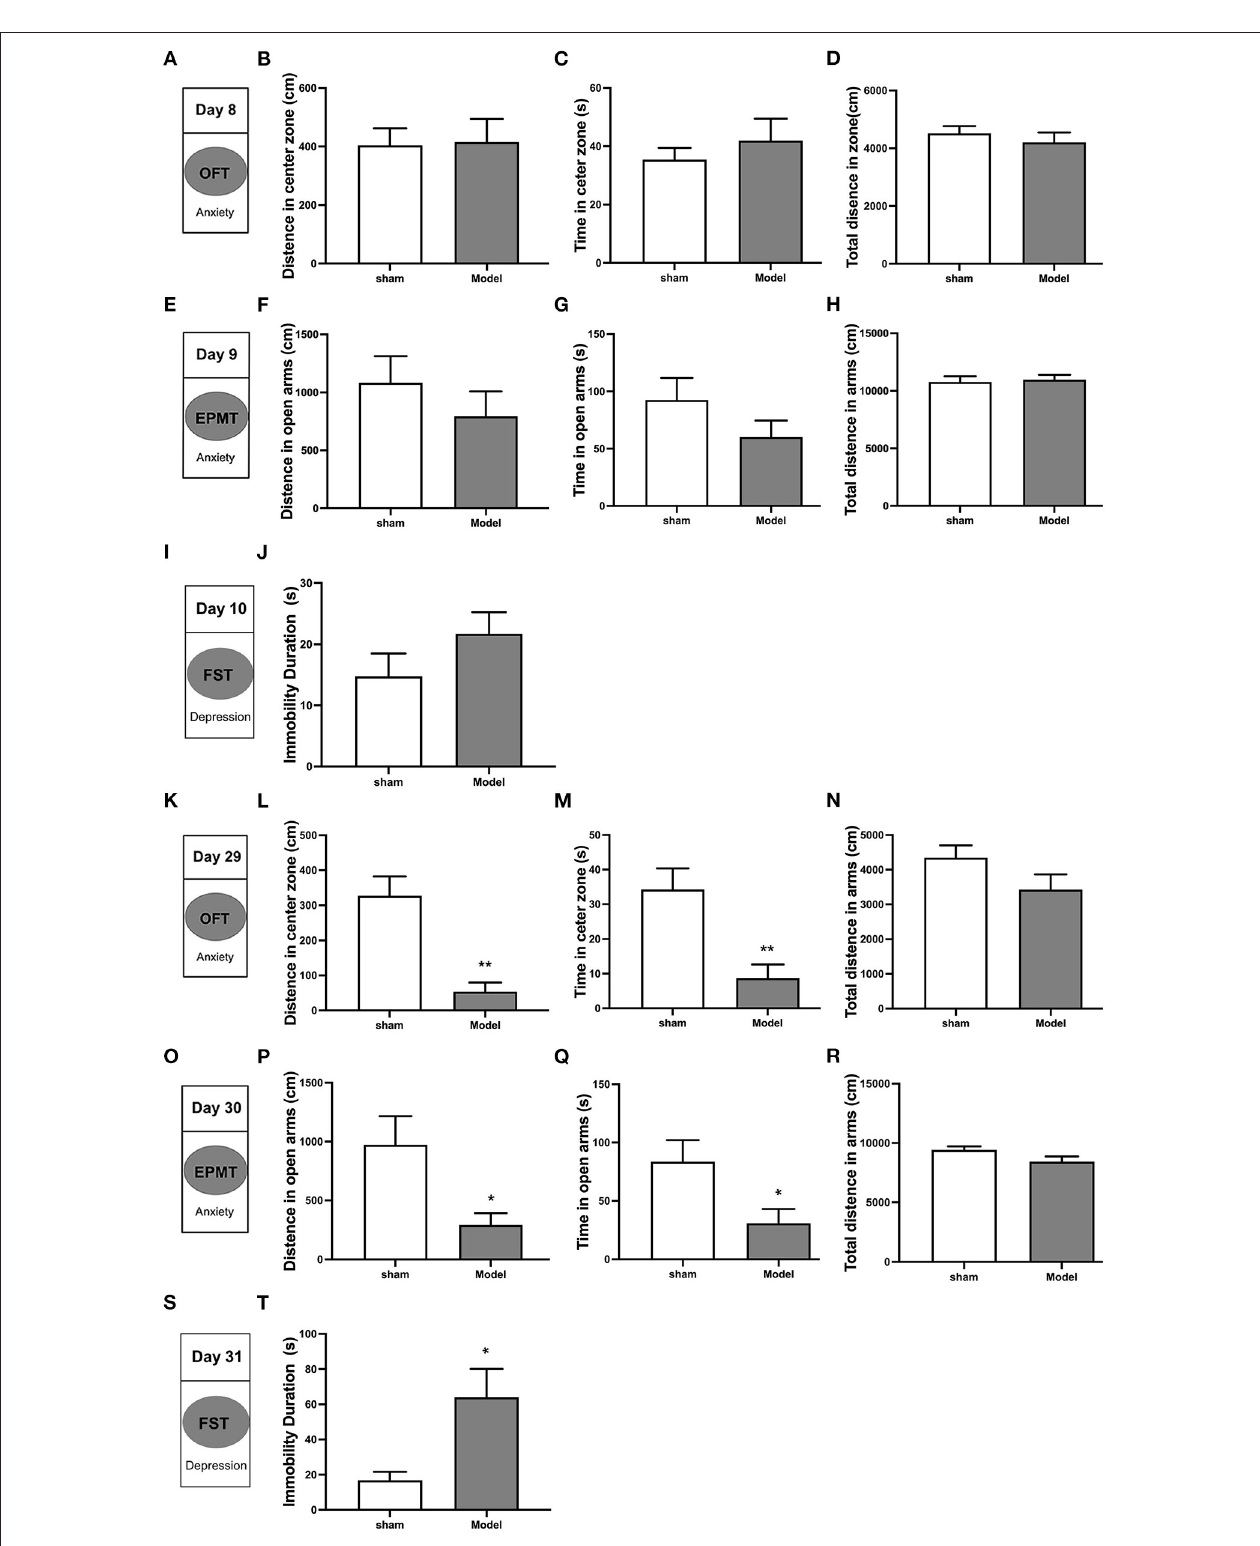
FIGURE 3 | Depressive and anxiety-like behaviors induced by CCI in rats. Anxiety-like behavior was accessed using both the open field test (OFT) (A–D, K–N) and the elevated plus maze test (EPMT) (E–H, O–R) . Depressive-like behavior was accessed using the forced swimming test (FST) (I,J,S,T) . (A,K) OFT was performed